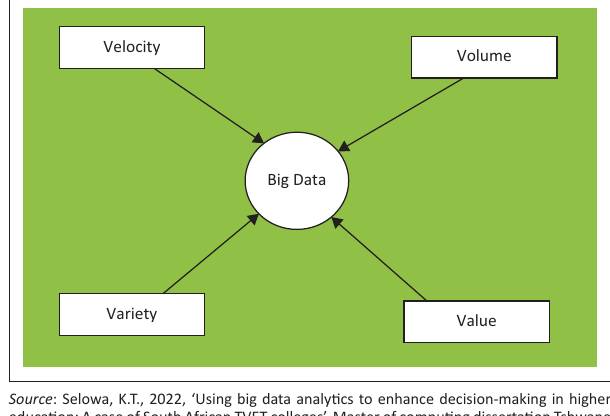
FIGURE 2: Vs of Big Data based on the definition